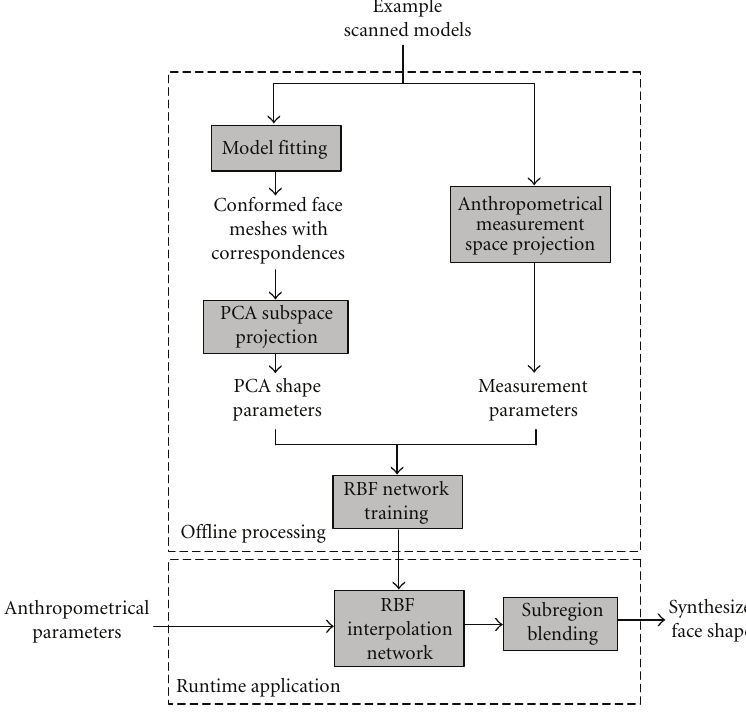
Figure 1: Overview of the interactive face shape synthesis system.